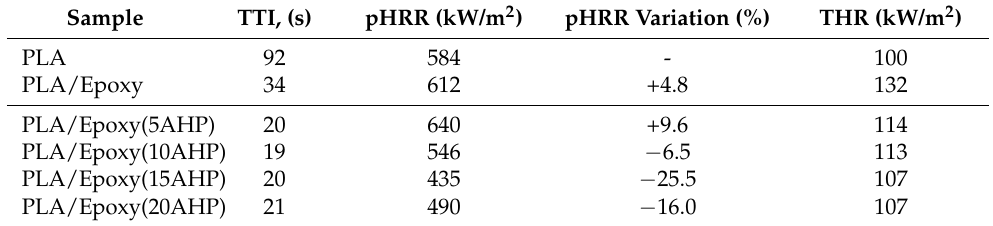
Table 4. MLC data (35 kW/m 2